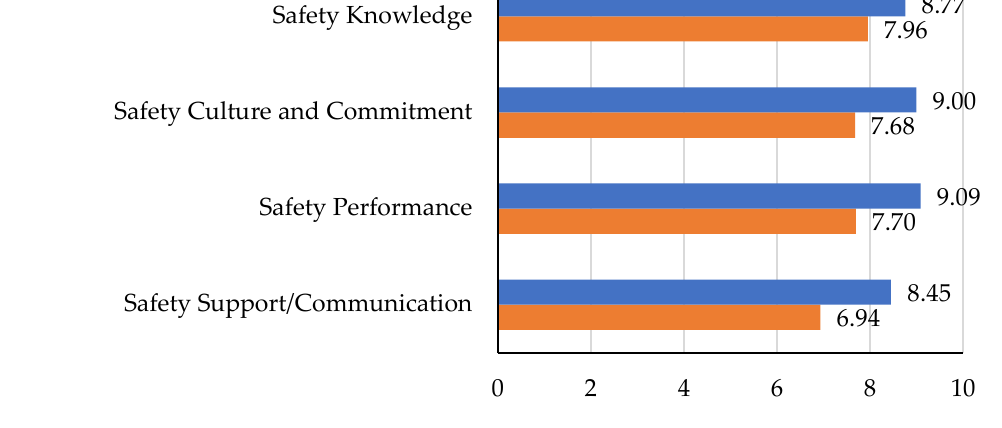
Figure 5. Managers’ safety evaluation.